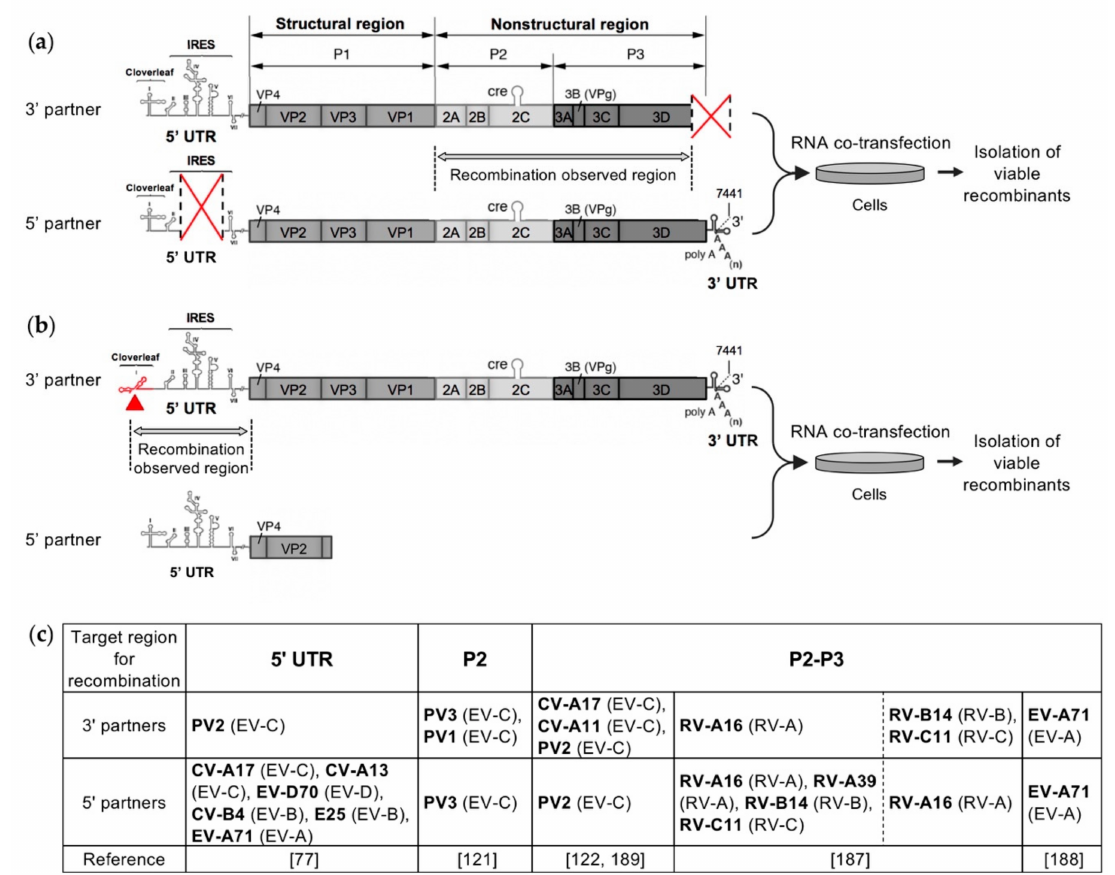
Figure 5. Experimental systems of intra- and intertypic recombination between enteroviruses. ( a ) and ( b ). Examples of recombination partners designed to target recombination in the P2-P3 region ( a ) and in the 5 (cid:48) UTR ( b ). ( a ) The 3 (cid:48) partner is made from the complete enterovirus genome in which the 3 (cid:48) end of the 3D polymerase and the entire 3 (cid:48) UTR were deleted. The 5 (cid:48) partner is made from the enterovirus genome carrying a deletion in the IRES. Red crosses indicate the genomic regions in which deletions were made. Co-transfecting cells with these two defective complementary genomic RNA fragments led to the production of infectious genomes recombinant in the P2-P3 region [122,189]. ( b ) The 3 (cid:48) partner is made defective by substitutions in the cloverleaf structure of 5 (cid:48) UTR. The 5 (cid:48) partner includes the complete 5 (cid:48) UTR followed by the N-terminal part of the ppORF. Co-transfecting cells with this pair of defective genomes will generate viable viruses only if a recombination event occurs in the 5 (cid:48) UTR [77]. ( c ) List of enterovirus types used for the construction of the 3 (cid:48) and 5 (cid:48) partners in the di ff erent experimental systems. For each type, the enterovirus species is indicated in